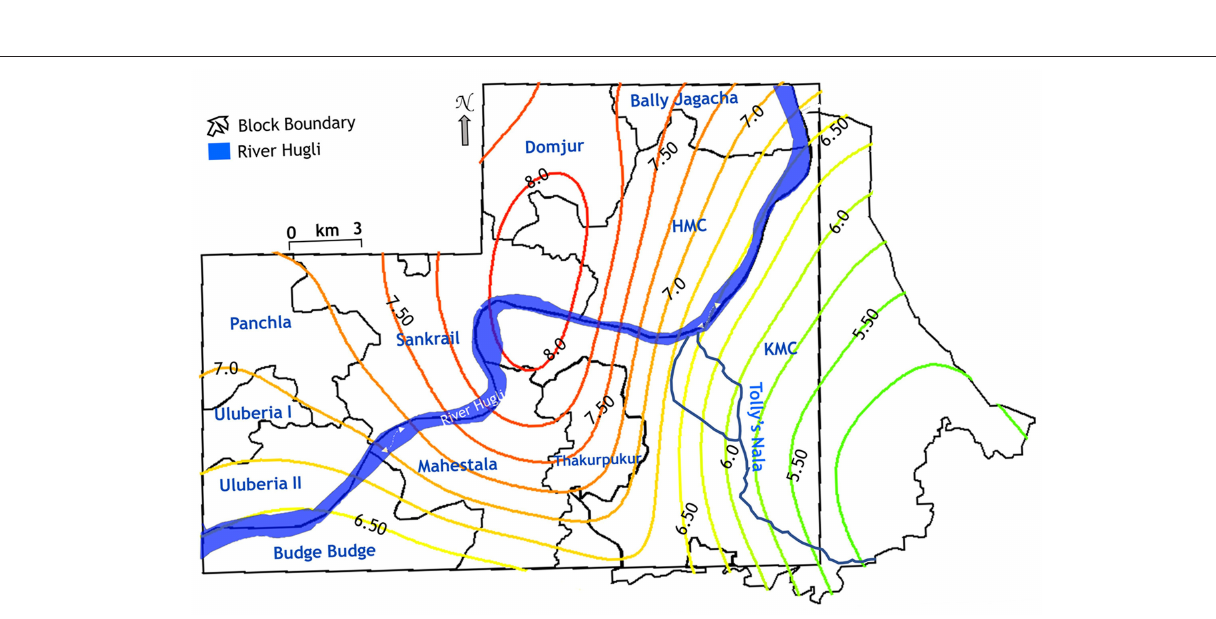
Frontiers in Water |